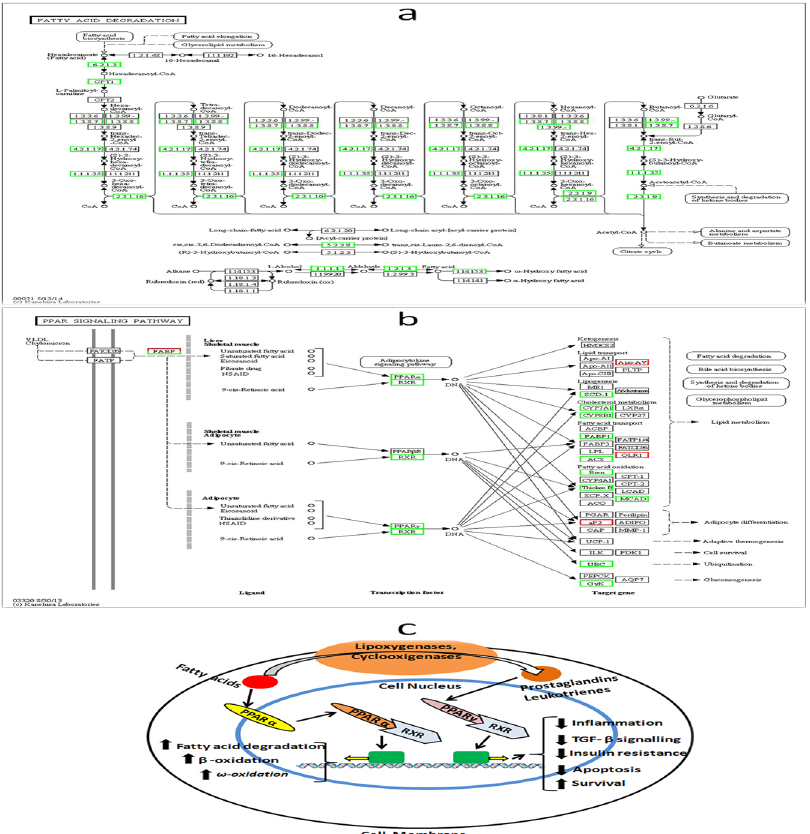
Figure 6. DEGs related to fatty acid degradation and PPAR α signaling pathway between APFL and AP. KEGG pathway maps for ( a ) fatty acid degradation pathway (ko00071) and ( b ) PPAR α signaling pathway (ko03320) 49 . Up-regulated genes are marked with red borders and down-regulated genes with green borders. Non-change genes are marked with black borders. Physiological function of the peroxisome proliferator activated receptors (PPARs) is shown in ( c